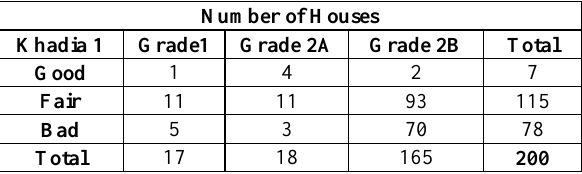
Table 1. Selection of sample for Khadia